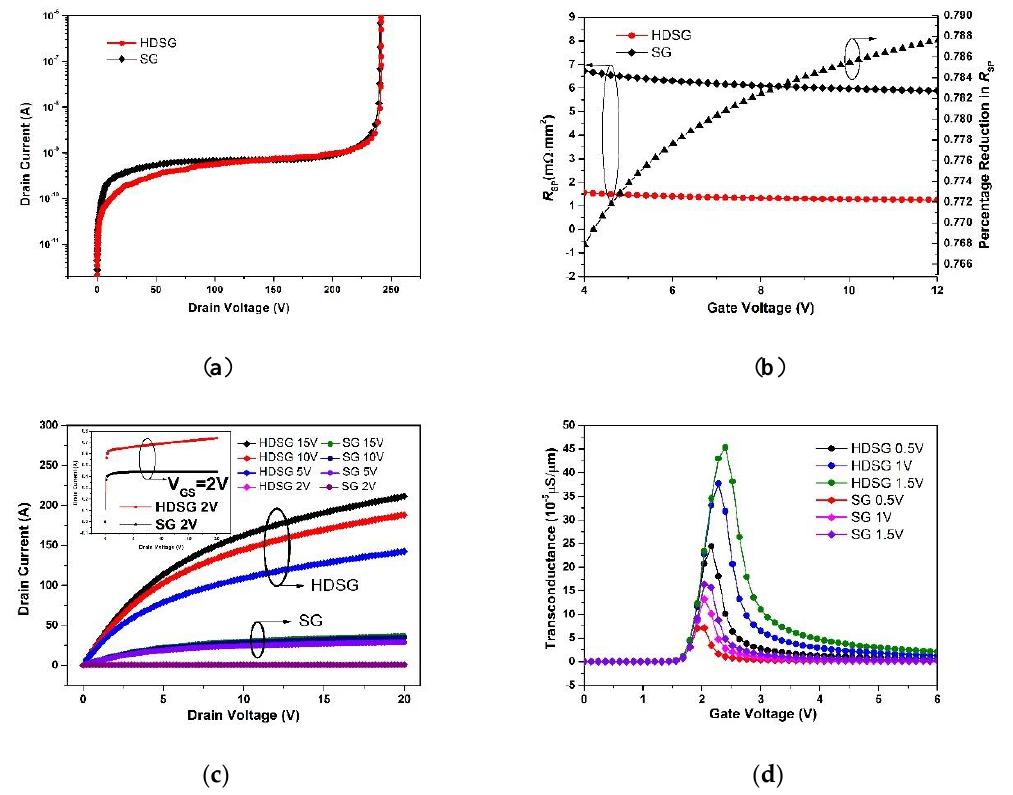
Figure 5. Drain I-V characteristics: ( a ) Breakdown Voltage (BV); ( b ) R SP at different gate voltage with V DS = 0.3 V and percentage reduction in R SP as compared with the SGRSO UMOSFET; ( c ) output characteristics and ( d ) transconductance of two structures.